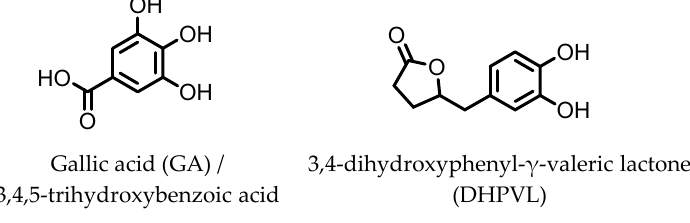
Figure 7. Structures of gallic acid and 3,4-dihydroxyphenyl- γ -valeric lactone.